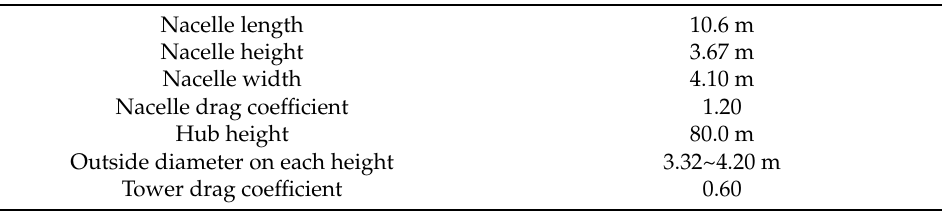
Table 2. Design specifications of nacelle and tower.